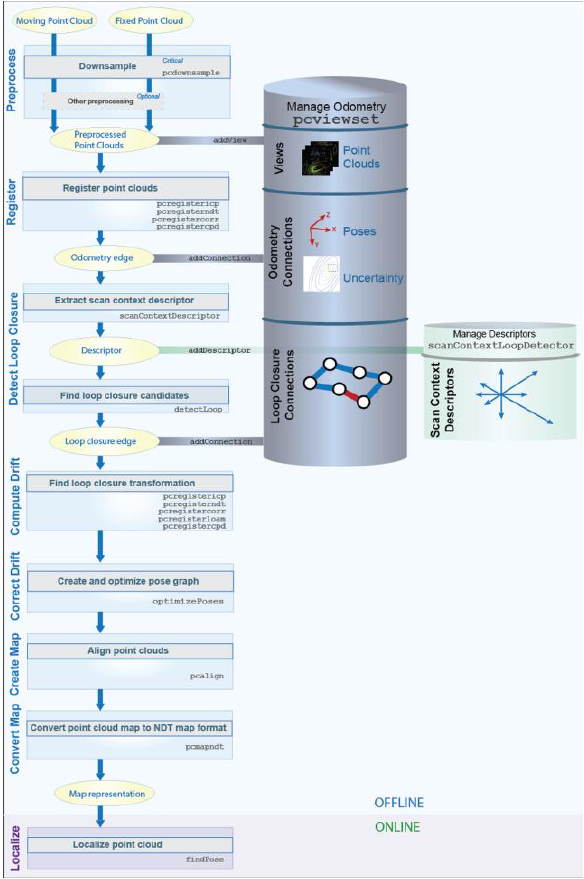
Figure 1. General workflow steps for Matlab LiDAR SLAM (Matlab